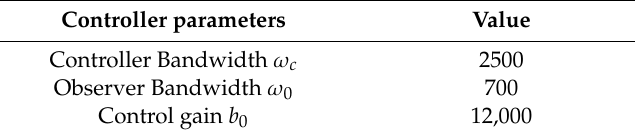
Table A2. Controller